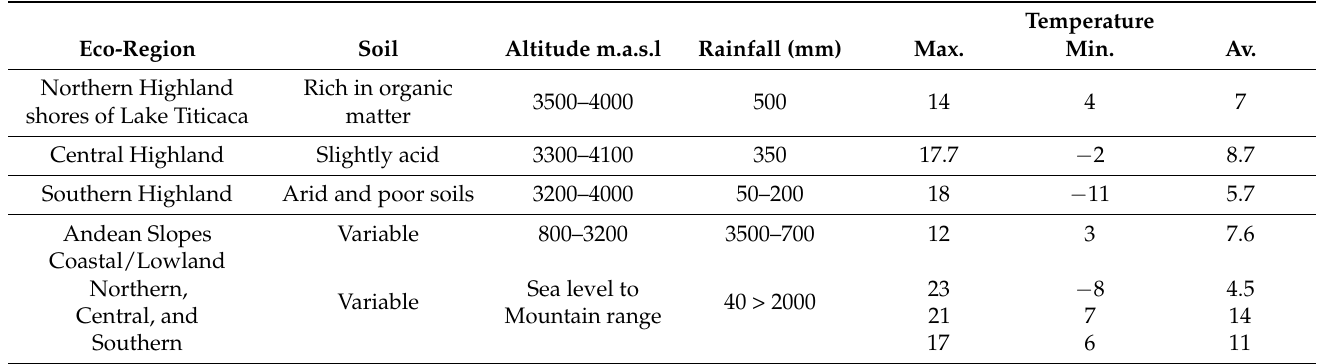
Table 6. Eco-regions for quinoa production in South